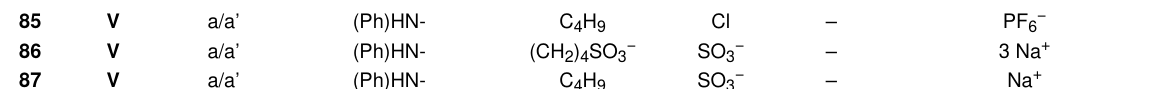
Table 1: Summary of structure elements of absorbers related to the structural patterns I – V . Table 2 summarizes their photophysical data. FEW Chemicals GmbH provided samples for the investigations.